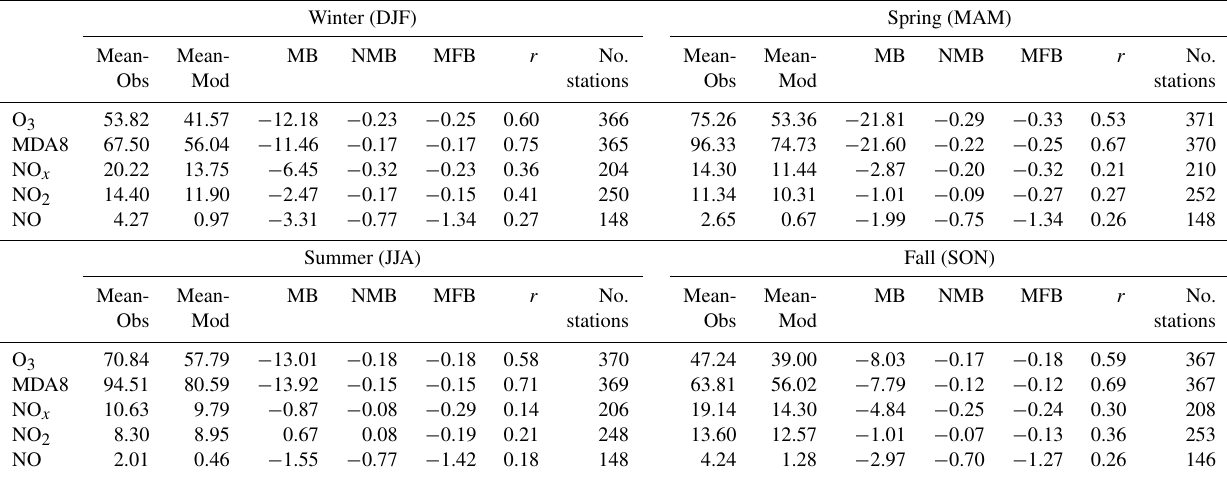
Table 8. Statistics for RADM2 simulation against hourly observations from the AirBase network. Means and MB are expressed in µgm − 3 ; NMB, MFB, and r are unitless. r is the hourly temporal correlation coefficient for all quantities except MDA8, for which it represents the daily temporal correlation coefficient.